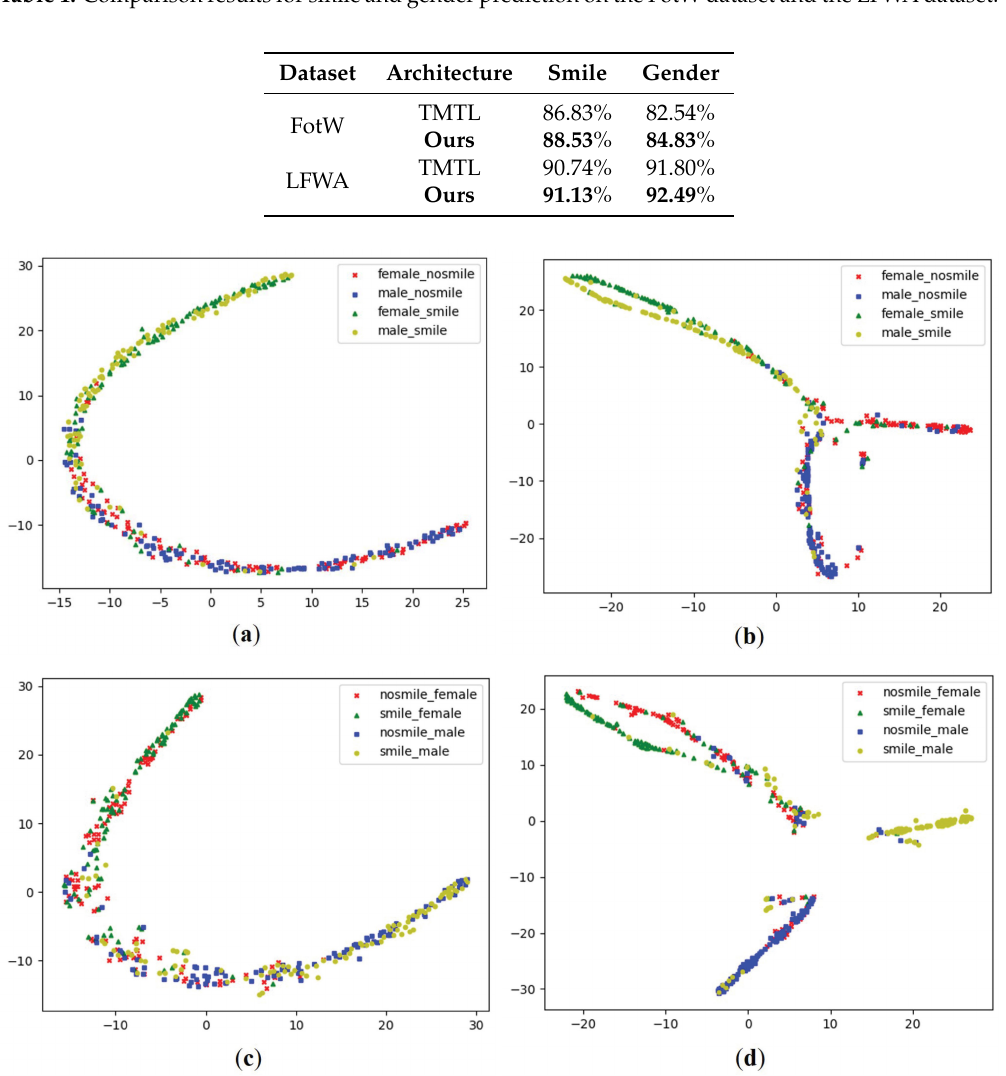
Table 1. Comparison results for smile and gender prediction on the FotW dataset and the LFWA dataset.